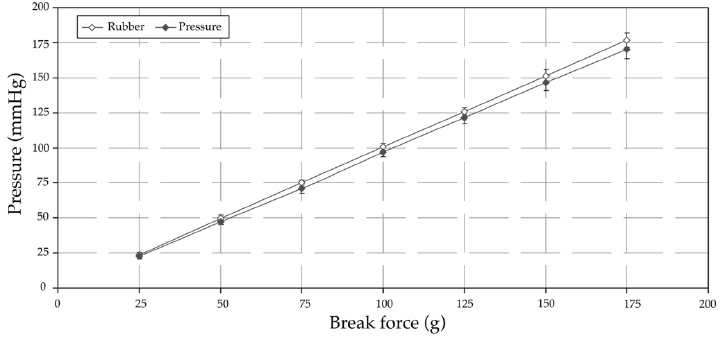
Figure 18. Static pressure sensor.